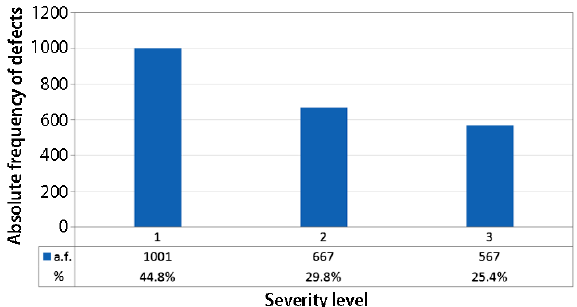
Fig. 8. Absolute frequency (a.f.) and percentage of defects diagnosed, according to their level of severity